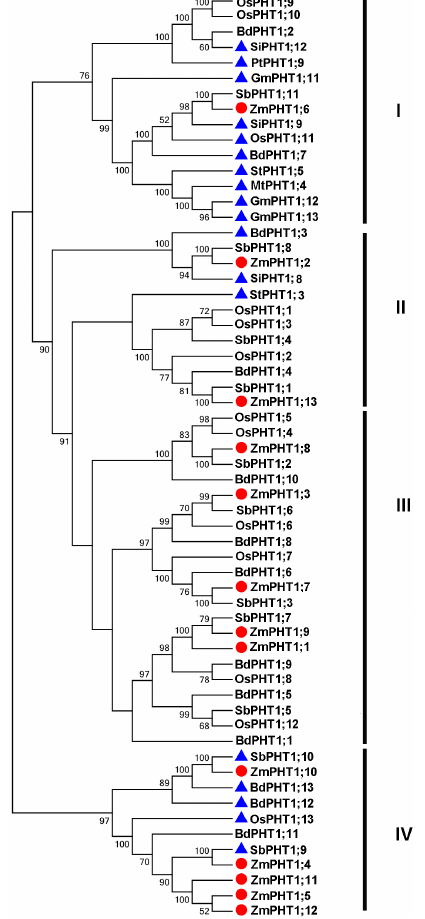
Figure 1. Phylogenetic analysis of PHT1 transporters between maize and other plants. Roman numerals ( I – IV ) indicate the four PHT1 subfamilies. Transporters from maize (ZmPHT1;1 to ZmPHT1;13), rice (OsPHT1;1 to OsPHT1;13), sorghum (SbPHT1;1 to SbPHT1;11), Brachypodium (BdPHT1;1 to BdPHT1;13) and some recently-identified AM-inducible PHT1 transporters [20]. ZmPHT1s are indicated by filled red circles, and AMF-inducible PHT1s in other plants are indicated by filled blue triangles.